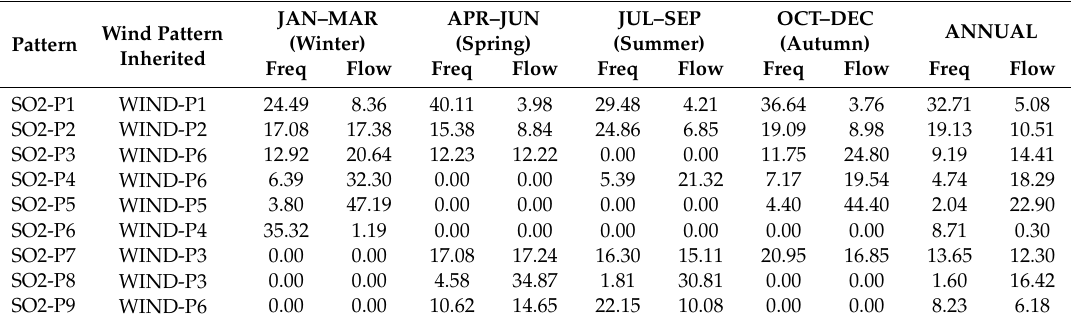
Table 7. Frequencies (%) and flows ( µ g / m 2 s) of the Mexico City SO 2 flow patterns (2001–2010). Pattern Wind Pattern Pattern Inherited